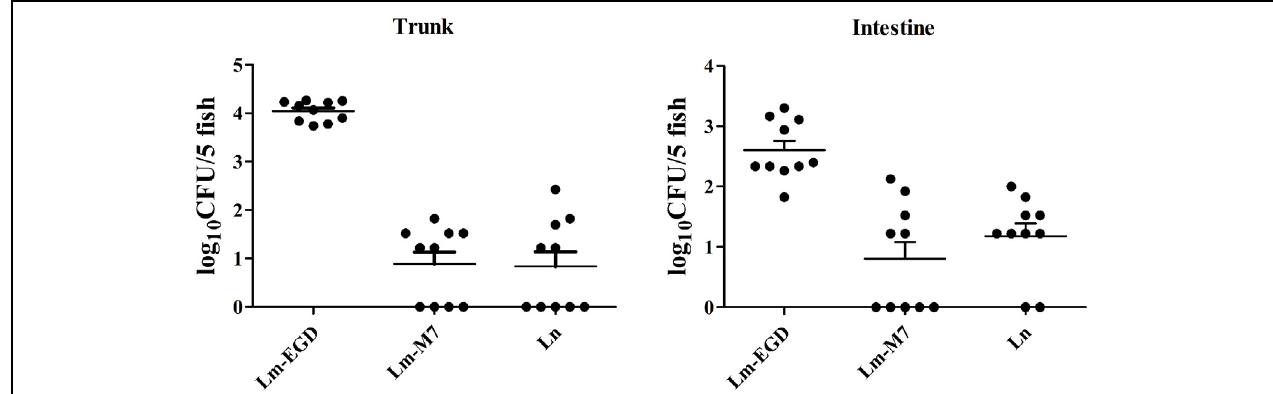
FIGURE 3 | Bacterial burden in the body trunk and intestine of L. monocytogenes EGDe infected germ-free fish was much higher than that of the strain M7 or L. innocua infected ones. The fish (50 per strain) were immersion-infected at 5 dpf and sacrificed at 24 hpi. The body trunk and intestine samples of each strain were